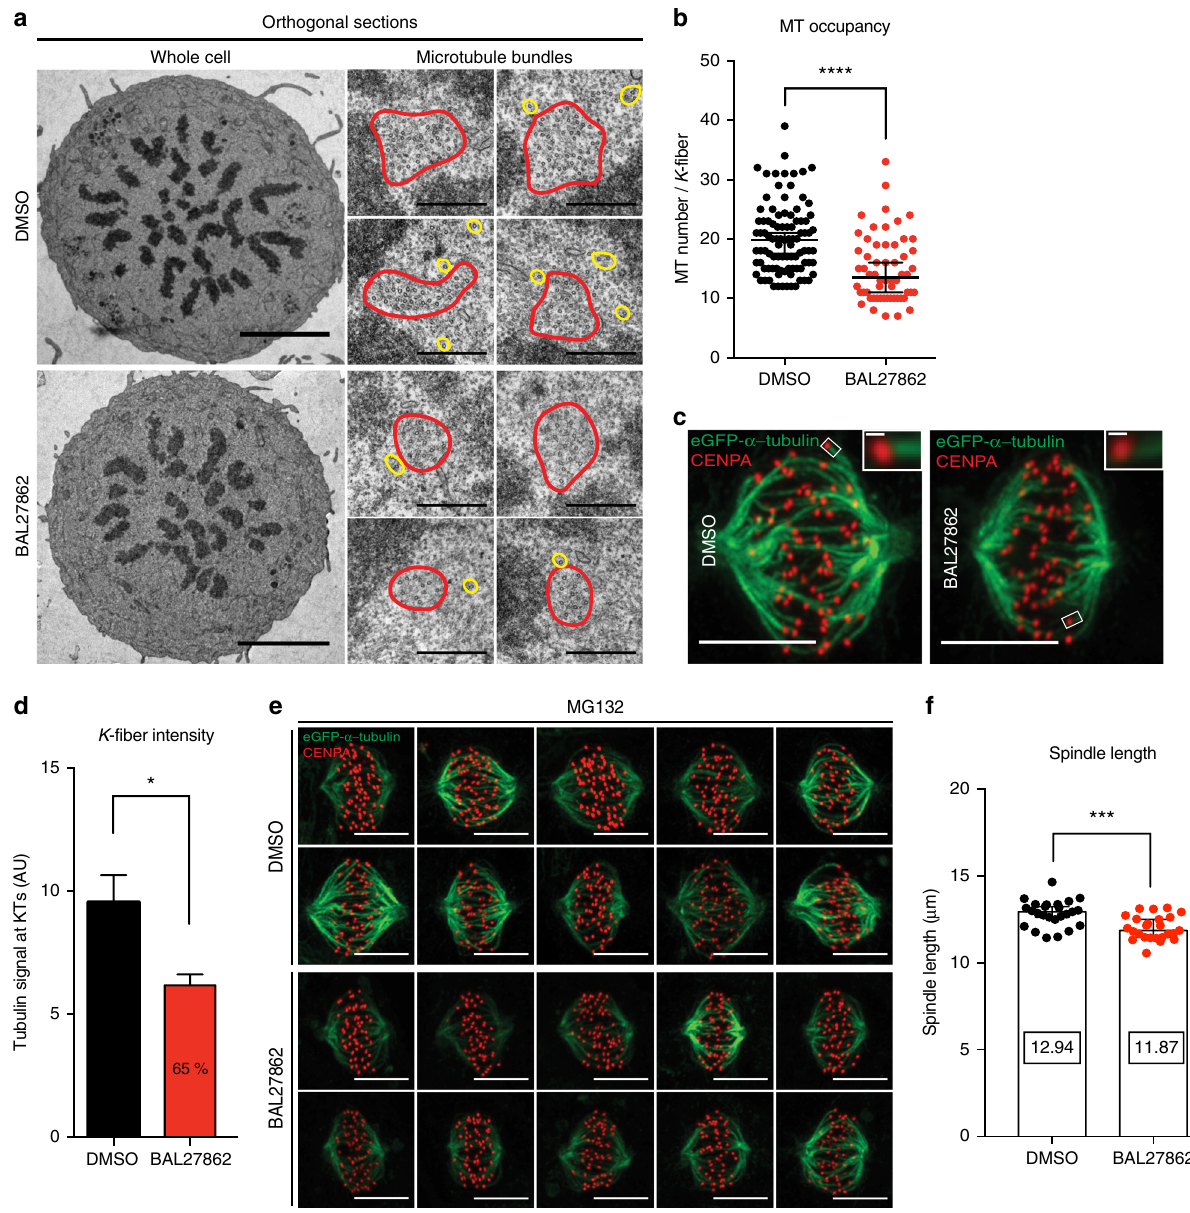
Fig. 1 BAL27862 reduces KT – MT occupancy. a Transmission electron microscopy orthogonal sections of hTert-RPE1 GFP-CENPA cells treated with DMSO or 12 nM BAL27862 and blocked in metaphase with 10 μ M MG132. Left panels show whole cells at low magni fi cation. Scale bars = 5 μ m. Right panel shows individual KT fi bres (red circles) or inter-polar MTs (yellow circles). KT fi bres were de fi ned as a set of at least 7 parallel MTs, in the vicinity of chromatin and not more than 80 nm separated from one another 38 . Scale bars = 500 nm. b Quanti fi cation of the number of MTs in KT – MT fi bres in hTert-RPE1 GFP- CENPA cells treated with DMSO or 12 nM BAL27862. Data are represented as a dot plot; error bars represent 95% CI of medians; each dot represents a single KT fi bre ( N = 3 independent experiments; n = 59 – 129 KT fi bres, p < 10 − 4 , two-tailed Mann – Whitney U -test). c Immuno fl uorescence images of hTert-RPE1 eGFP- α -tubulin (green) cells treated either with DMSO or 12 nM of BAL27862 (4 h) and 10 μ M of MG132 (2 h) and stained with anti-CENPA antibody (red). Scale bars = 5 μ m. Insets show a KT-proximity area measurement. Scale bars = 250 nm. d Quanti fi cation of eGFP- α -tubulin intensities at KTs in DMSO and BAL27862-treated cells. N = 3, n = 1135 – 1156 k - fi bres from 29 to 30 metaphase-arrested cells per condition, error bars represent s.e.m., p = 0.045, two-tailed t -test. e Immuno fl uorescence images of 10 randomly selected hTert-RPE1 eGFP- α -tubulin cells from a single experiment. Cells were treated in parallel with DMSO or 12 nM BAL27862, 10 μ M of MG132, and stained with anti-CENPA antibodies (red). Scale bars = 5 μ m. f Quanti fi cation of spindle length in hTert-RPE1 Centrin1-GFP/GFP-CENPA cells treated with DMSO or 12 nM BAL27862. N = 4, n = 25 cells; error bars represent 95% CI of medians, p = 0.0002, two-tailed t -test. *, **, ***, **** represent p <0.05, <0.01, <0.001, <0.0001 MT occupancy controls inter-KT stretching . To test whether marginally shorter when measured from live cell images of hTert- RPE1 Centrin1-GFP (centrosome marker)/GFP-CENPA cells reduced MT occupancy affects KT conformation, we investigated (Fig. 1f). We conclude that nanomolar concentrations of whether BAL27862 affected the distance between inner and outer BAL27862 decrease MT occupancy at KTs by ~1/3rd, while KT structures. To do this we determined the sub-pixel position of preserving bipolar spindle integrity. GFP-CENPA (centromere/inner KT) and the amino-terminus of